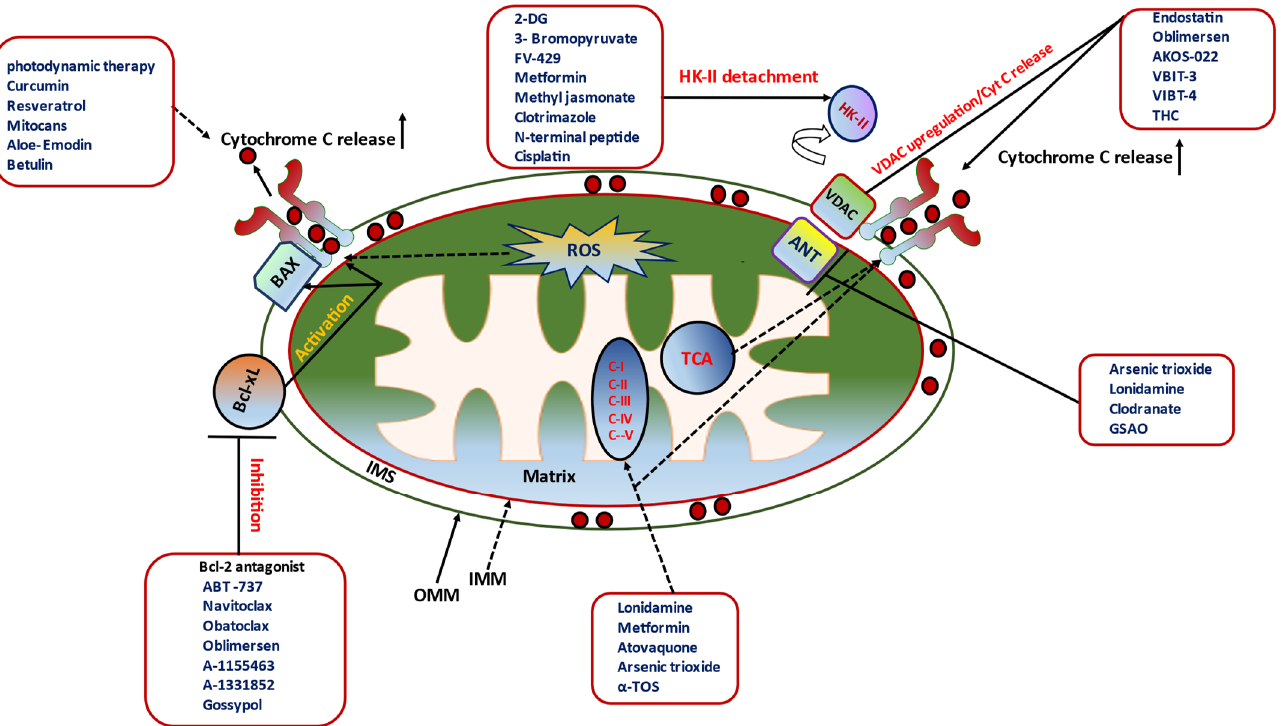
Figure 4. Pharmacologically targeting mPTP-mediated cancer cell death signaling in mitochondrion using chemotherapeutic agents and natural compounds.